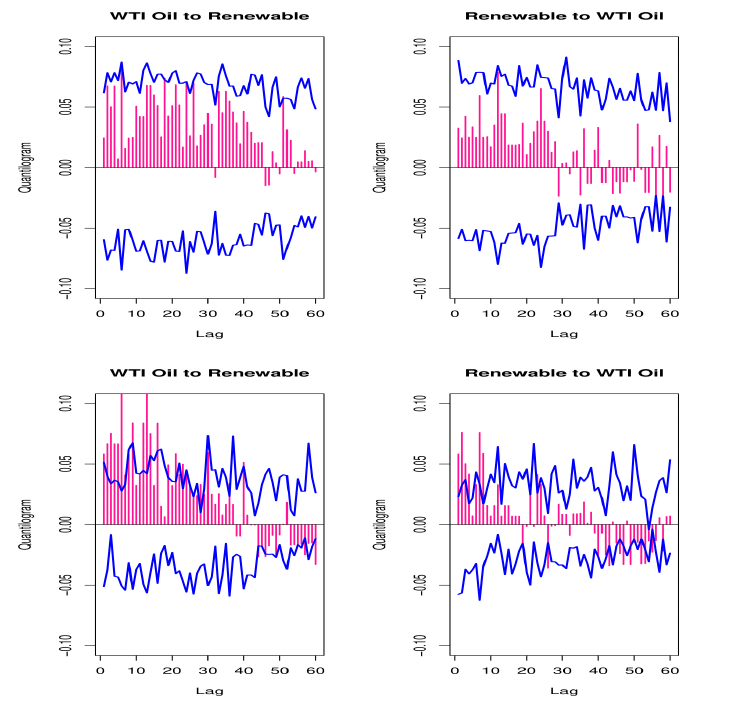
Figure 13. Cross-quantilogram. In the upper the Cross-quantilogram plot for θ = 0.95 (good), while in the lower for θ = 0.05